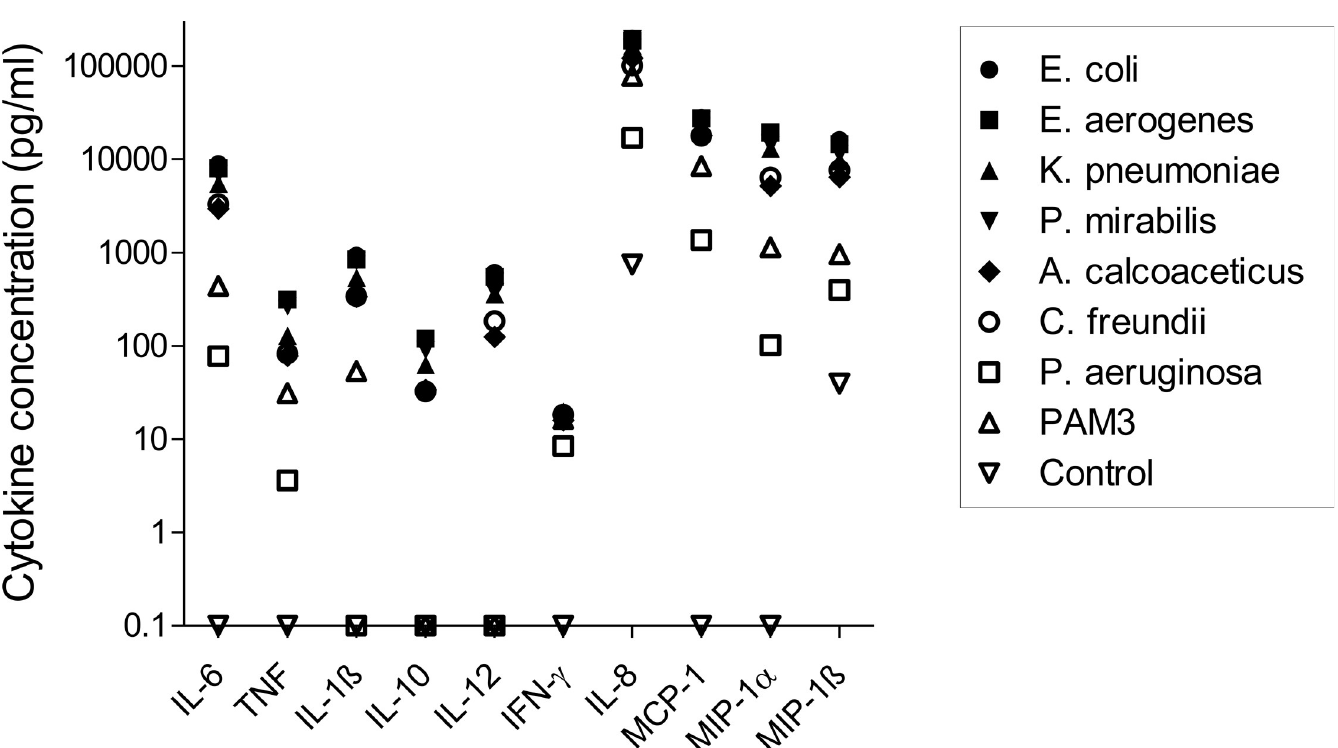
Fig 7. Summary of the cytokine profiles in UBMC stimulated with LPS of seven gram-negative bacteria. Median cytokine levels in LPS-stimulated UBMC isolated from ten uncomplicated deliveries. Median cytokine levels are directly derived from the data presented in Fig 6. Due to log scale representation, values of 0 pg/ml were replaced by 0.1; thus values depicted at 0.1 pg/ml along the x axis are actually equal to zero. IL-8, IL-6, MIP-1 α , MIP-1 β and MCP-1 showed the highest median level of induction, followed by TNF, IL-1 β , IL-10 and IL-12. IFN- γ showed the lowest median level of secretion.